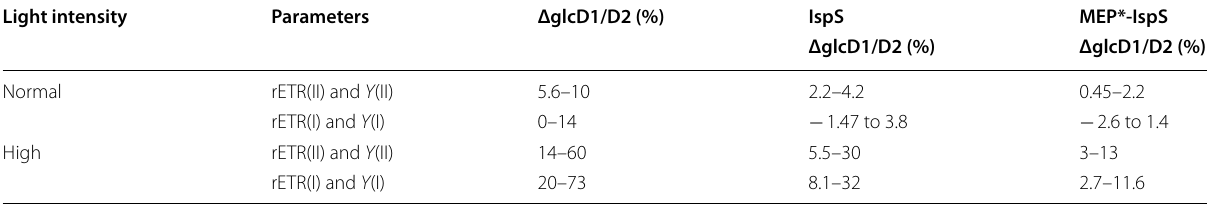
Normal light intensity, 60–100 μmol m − 2 s −